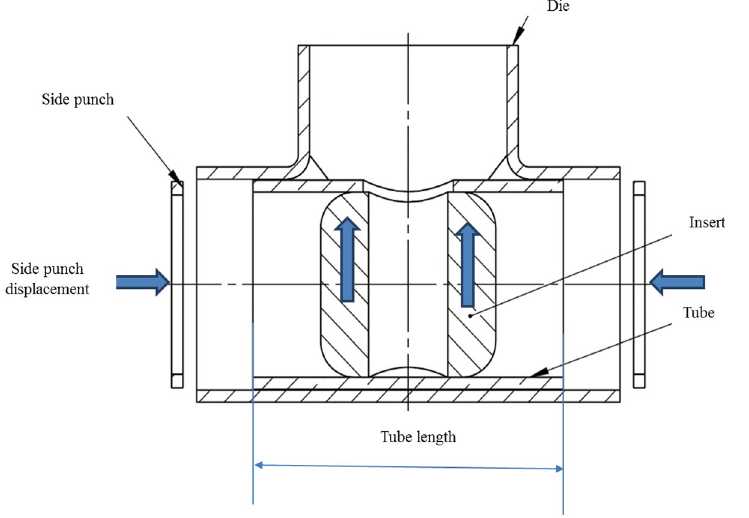
Fig 7. T-shaped tube fitting process parameters.